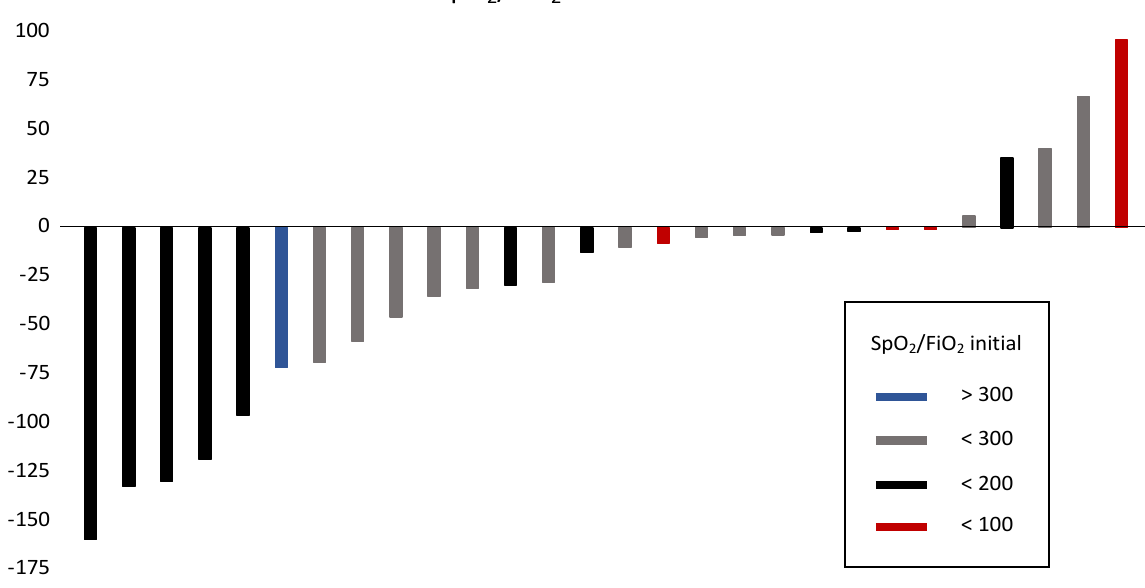
Figure 2. Change in SpO 2 /FiO 2 between the starting and arrival intensive care units among 28 transferred patients.